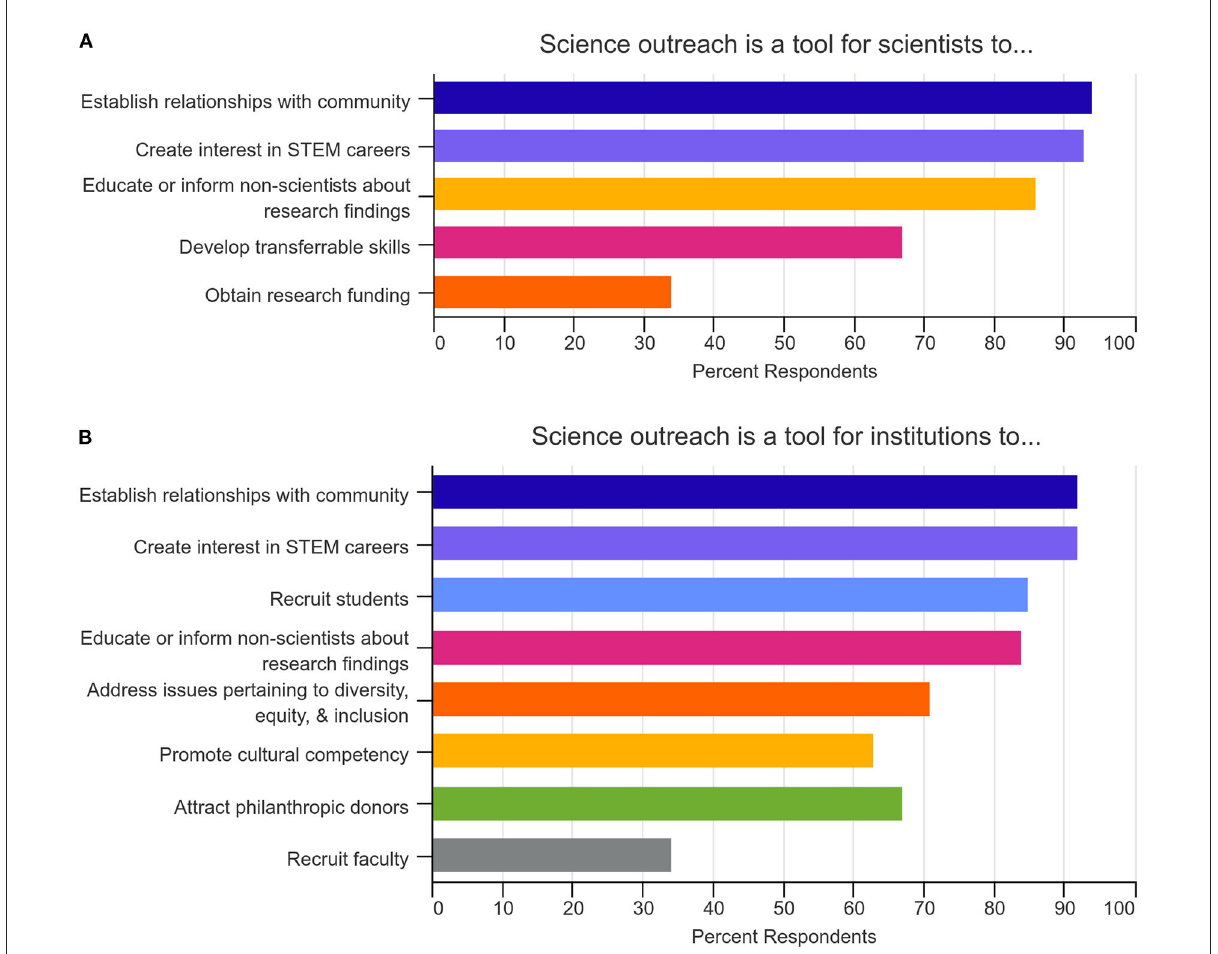
FIGURE4 Respondents’ attitudes toward the perceived utility of science outreach. (A) The percentage of respondents who agree that science outreach is tool for scientists to accomplish various tasks or initiatives. (B) The percentage of respondents who agree that science outreach is a tool for academic institutions to accomplish various tasks or